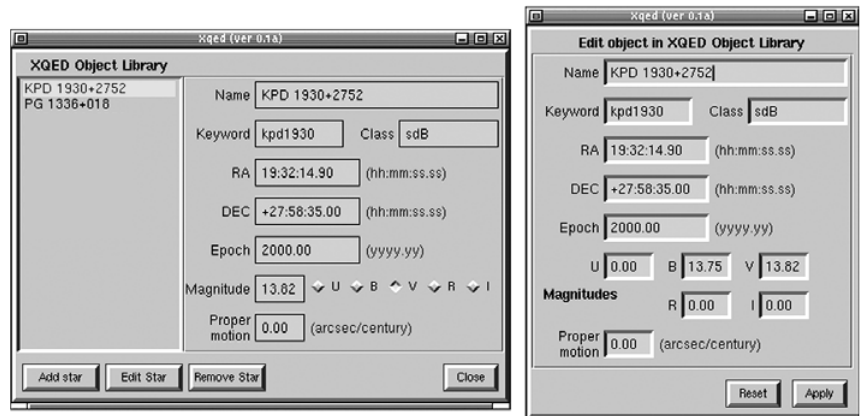
Fig. 2. Library interaction windows. The left window is the library list; selecting from the list displays object information. It is also possible to Add an object, Remove an object from the list or Edit an object (shown to the